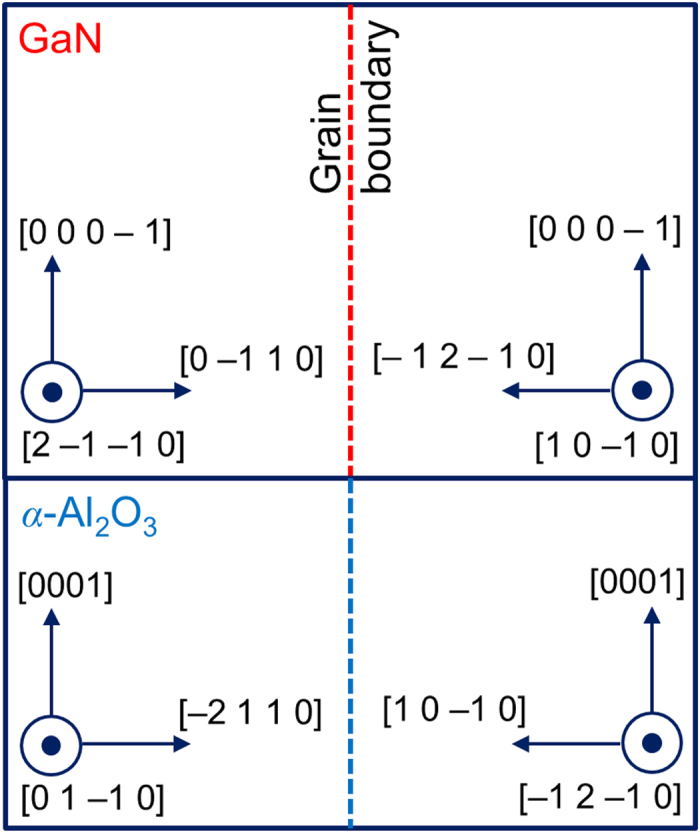
Fabrication of a GaN bicrystal.Cross-section schematic diagram of a GaN bicrystal deposited on the α-Al2O3 bicrystal substrate.